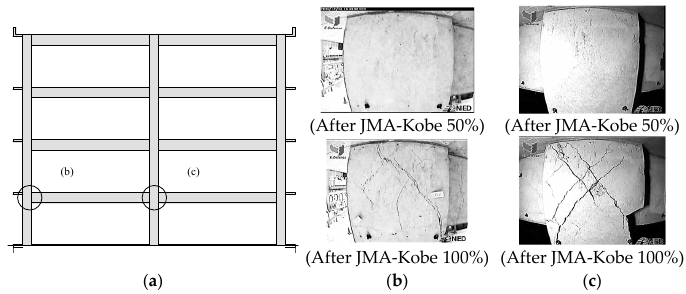
Figure 2. Beam–column damage observations: ( a ) recorded location; ( b ) damage of exterior beam– column joint after the JMA-Kobe tests with amplitudes 50% and 100%; and ( c ) damage of interior beam–column joint after the JMA-Kobe tests with amplitudes 50% and